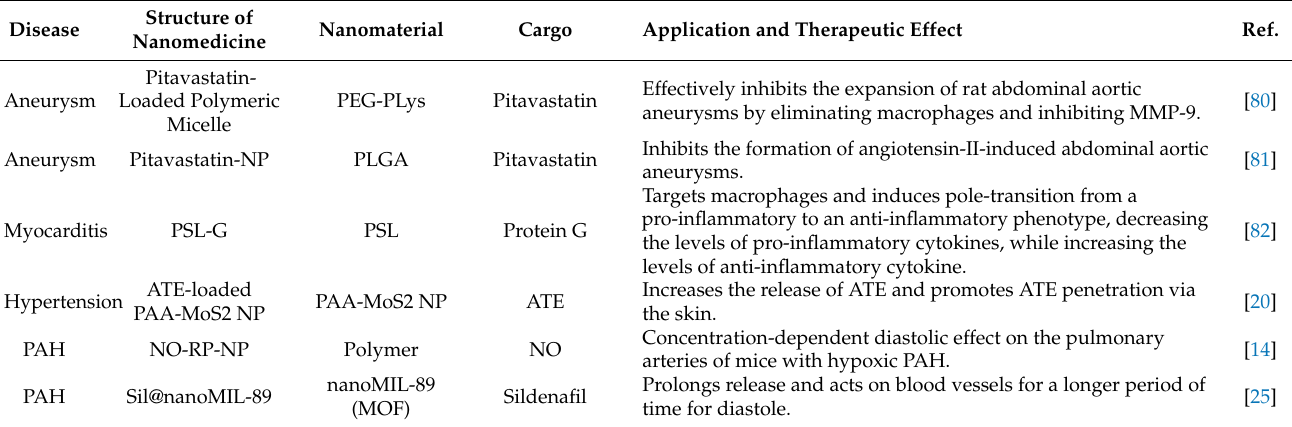
Table 3. Different approaches based on nanoparticles for the treatment of aneurysm, myocarditis, hypertension and